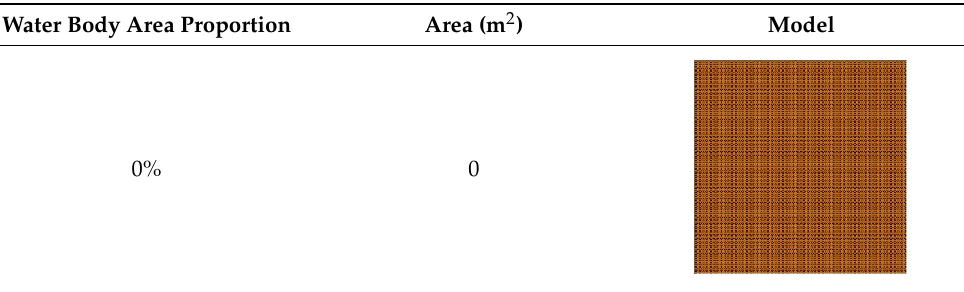
Table 1. Different water body area proportions model settings.